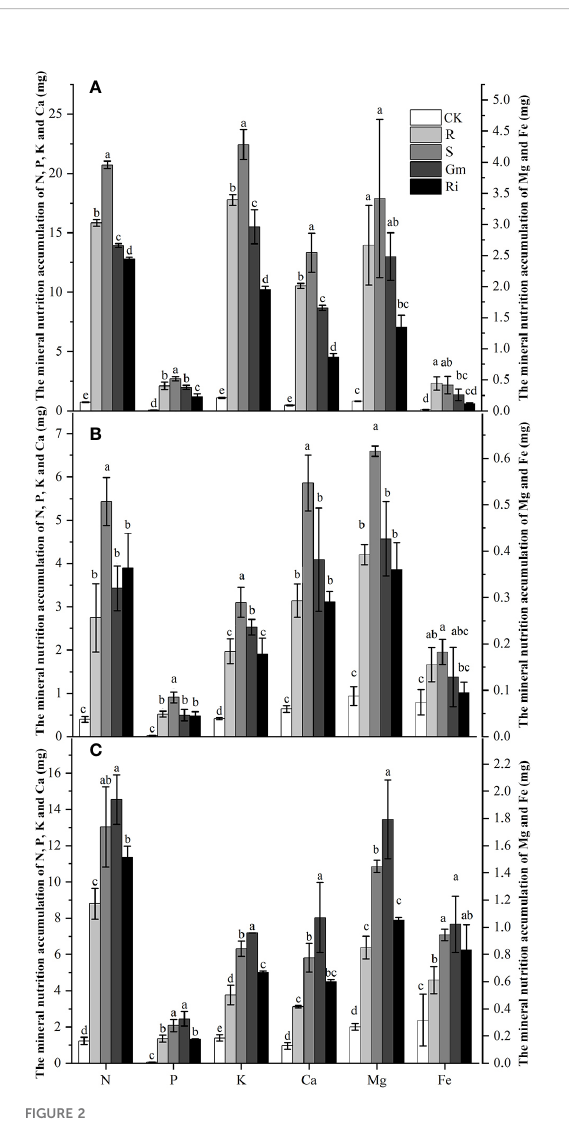
FIGURE 2 The mineral nutrition accumulation of Pyrus betulaefolia in different treatment. (A) Mineral nutrition accumulation of leaves (A) , stem (B) and root (C) . CK, sterilized soil from CK in Trifolium repens mixed with sterilized standard soil; R, soil from R in Trifolium repens mixed with sterilized standard soil; S, soil from S in Trifolium repens mixed with sterilized standard soil; Fm, Funneliformis mosseae inoculum mixed with sterilized standard soil; Ri, Rhizophagus intraradices inoculum mixed with sterilized standard soil. Data (means ± SD, n = 3) followed by different letters indicate that values are signi fi cantly different ( p < 0.05) within the